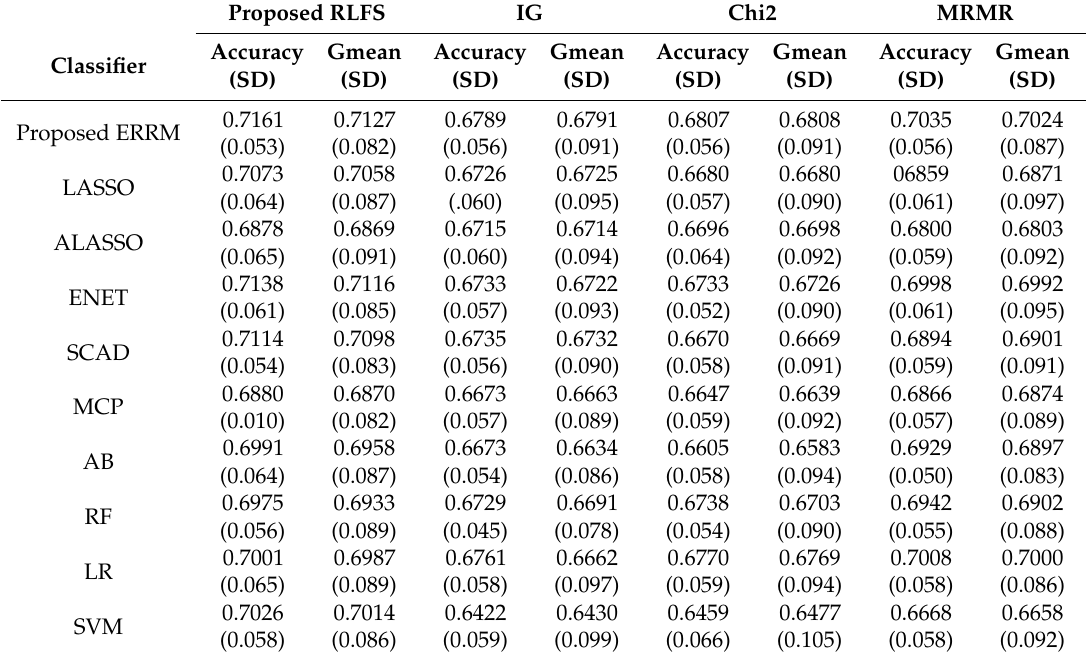
Figure 5. Boxplot showing the accuracies of classifiers with FS methods in experimental data SMK-CAN-187. Table 2. Average values taken over 100 iterations in experimental data: